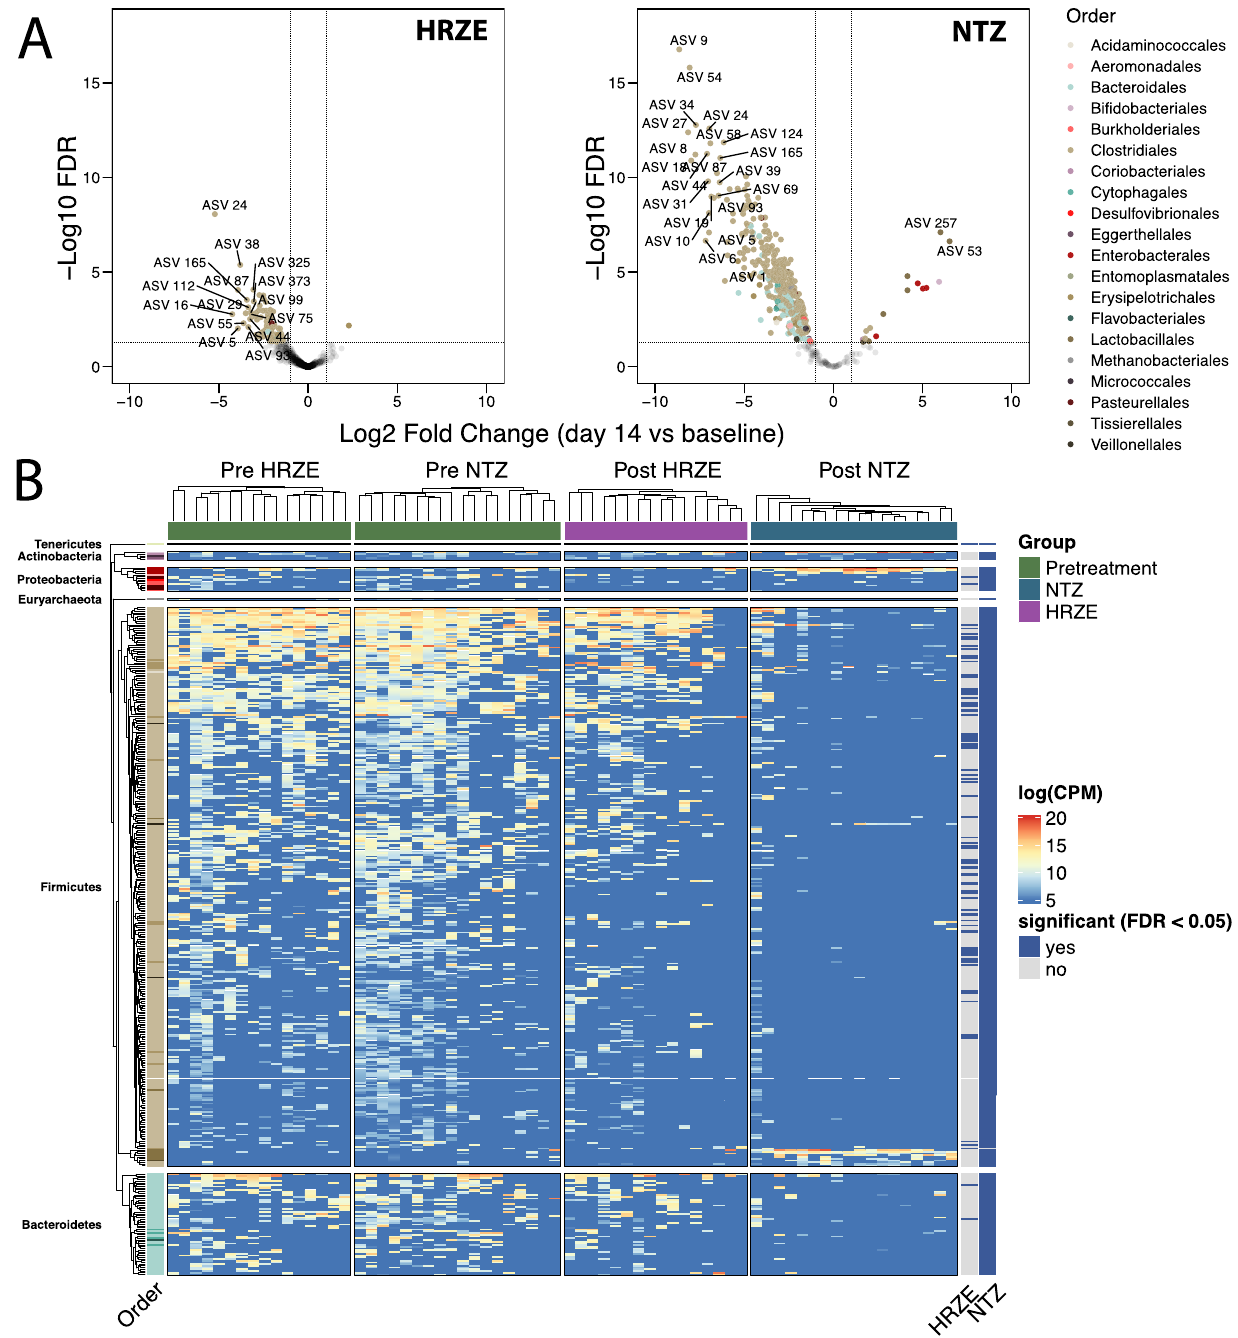
Fig. 3 Overlapping and distinct microbiome perturbation induced by NTZ and HRZE. A Volcano plots indicating the post (day 14) vs pretreatment (baseline) differences at the ASV level for HRZE and NTZ. The color of each ASV is according to the phylogenetic Order. A single linear mixed effect model for each ASV of the form ASV i counts ð Þ (cid:2) Sex þ Batch þ Group þ 1 j ID was fi tted to determine differences due to treatment while accounting for sequencing batch and sex. ASVs signi fi cantly affected by the treatment were those determined to have a Benjamini-Hochberg false discovery rate (FDR) adjusted p- value less than 0.05 for the variable Group in the limma/voom model (see “ Methods ” section). The horizontal dotted lines indicate FDR < 0.05 and vertical dotted lines indicate |log2FC| > 1.5. B Within-arm unsupervised hierarchical clustering of the abundances of 404 ASVs found to be signi fi cantly affected by HRZE or NTZ treatment (FDR < 0.05, see Supplementary 5). The heatmap columns are split by arm membership (including baseline randomization group), and the heatmap rows are split by ASV phylogenetic Phylum, and within the Phylum, the Order is colored as in A . The right annotations (HRZE and NTZ) indicate whether each ASV was signi fi cantly perturbed by treatment. P value in y axis is adjusted according to Benjamini – Hochberg (FDR). Source data are provided as a Source Data fi